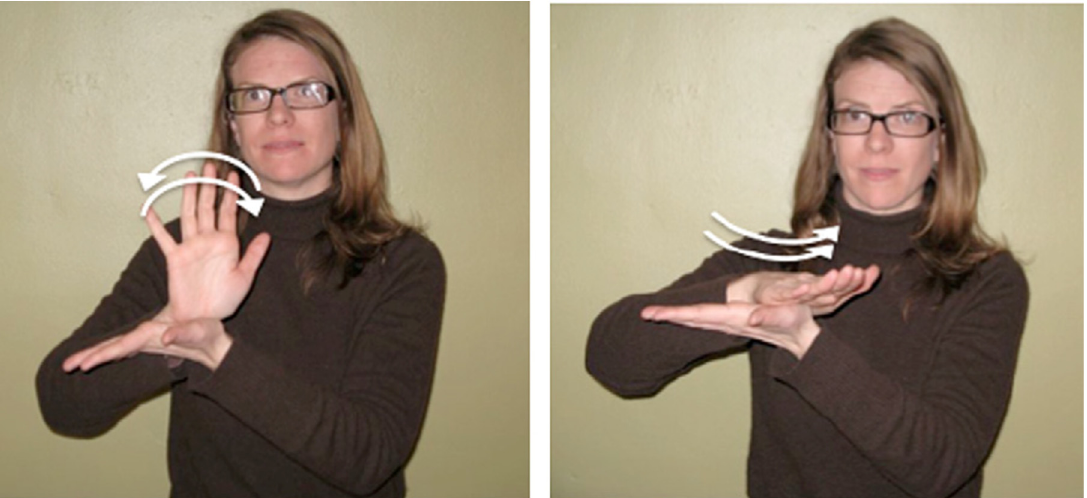
Figure 1. ASL signs for MOVIE ( left ) and PAPER ( right ). Reprinted with permission from Morford et al. (2011). Copyright 2011 Elsevier.